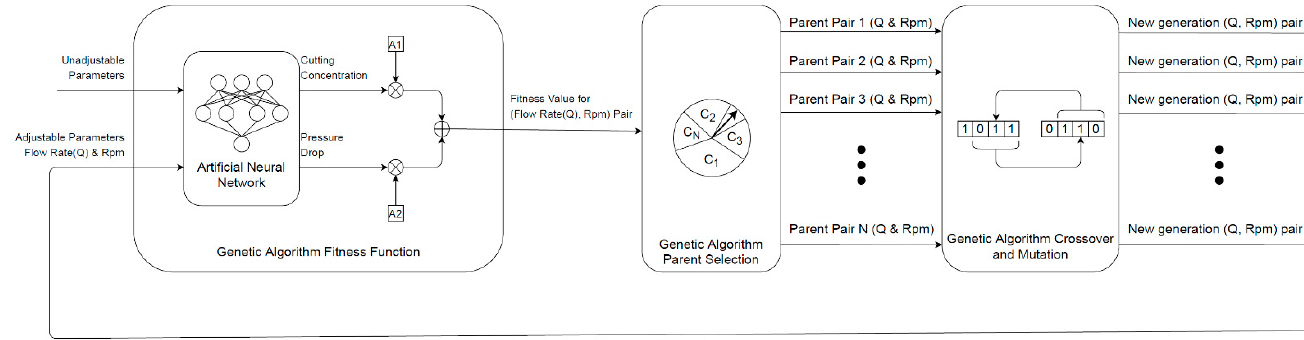
Figure 1. Schematic representation of the genetic algorithm method used in this study.